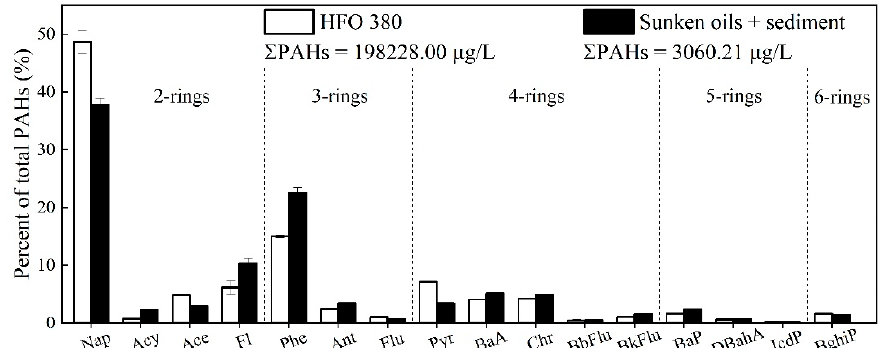
Figure 3. The distribution of PAHs in the sunken oils in the presence of quartz sand.